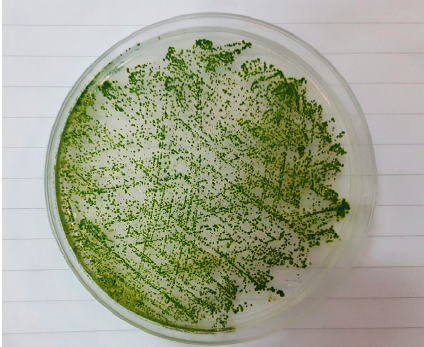
Figure 1: An agar plate streaked showing small isolated colonies arising from a single